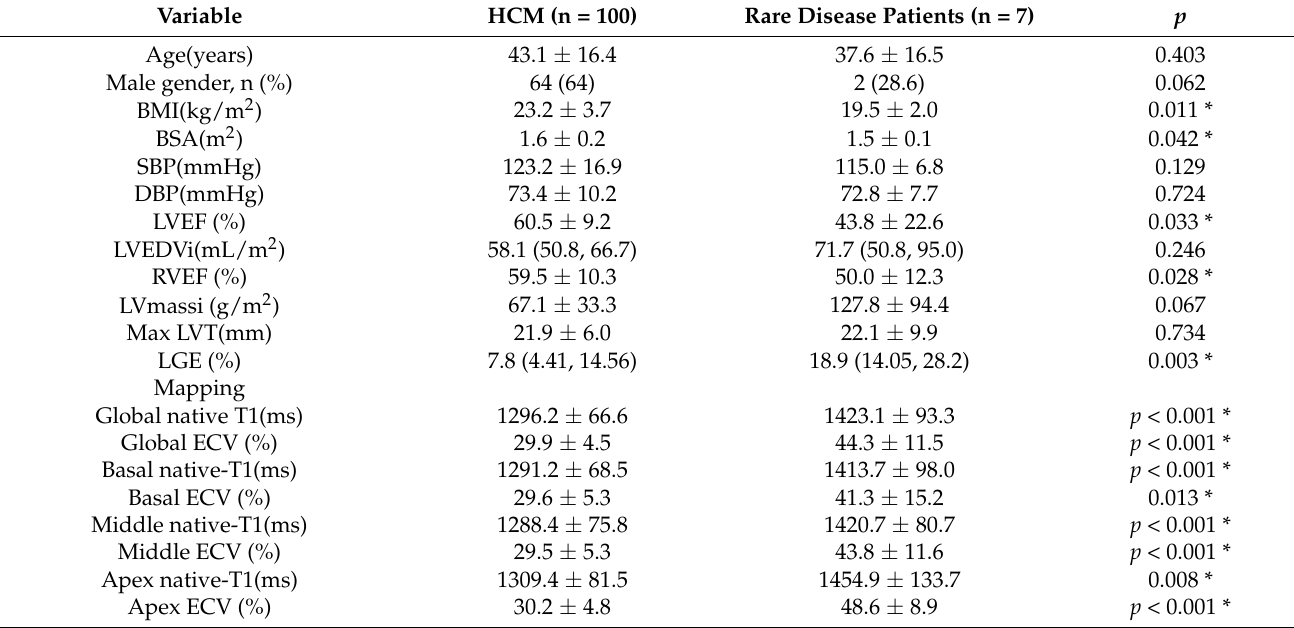
Table 2. Demographic, clinical and cardiac MRI-phenotypic characteristics between HCM patients and rare disease patients.